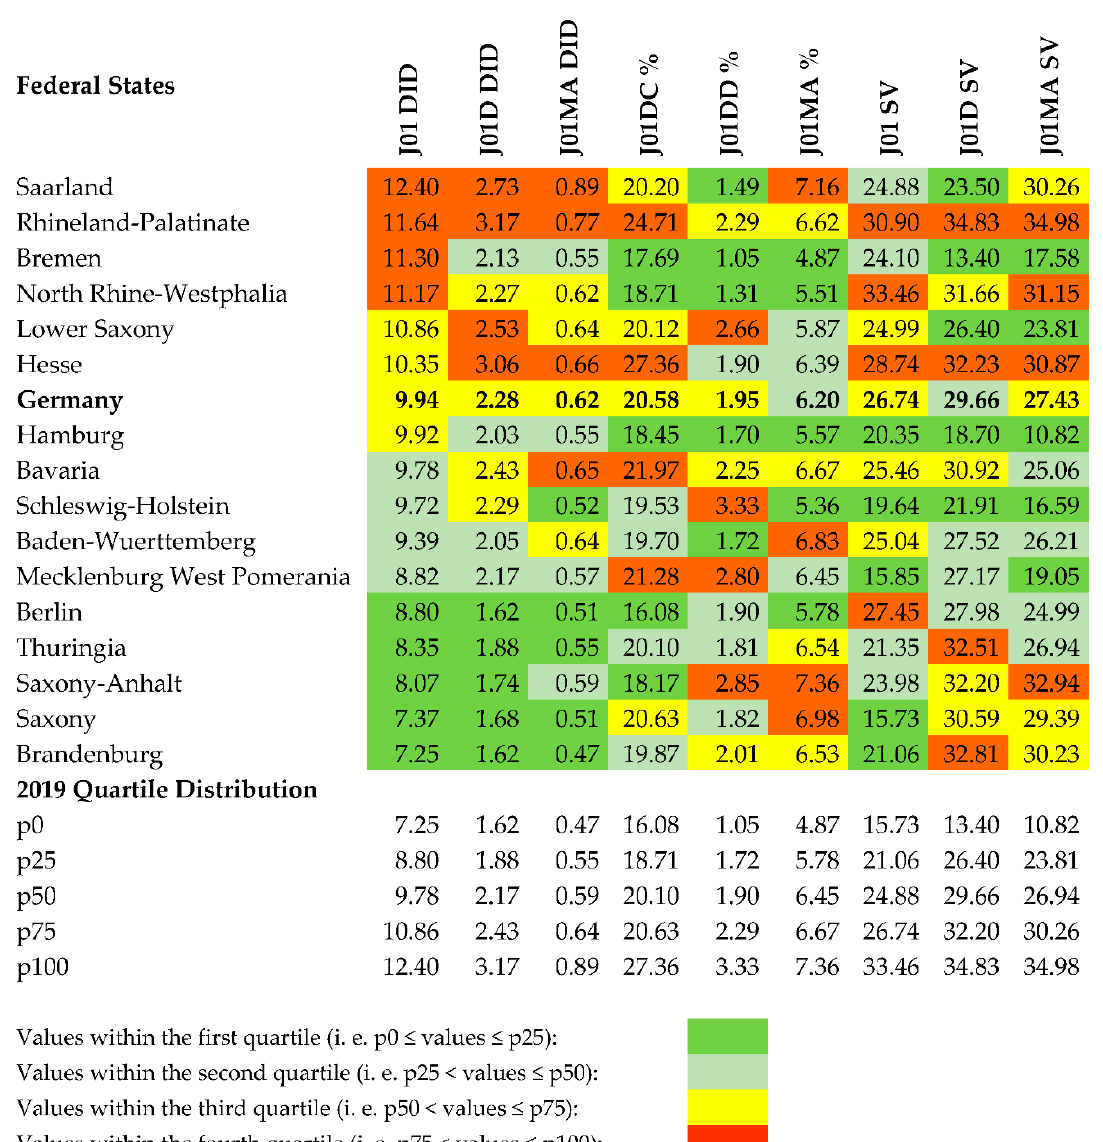
Figure 1. Quality indicators for ambulatory use of oral antibiotics, cephalosporins and fluoroquinolones; 2019 values for Germany and the 16 federal states grouped into quartiles based on the 2019 quartile distribution.